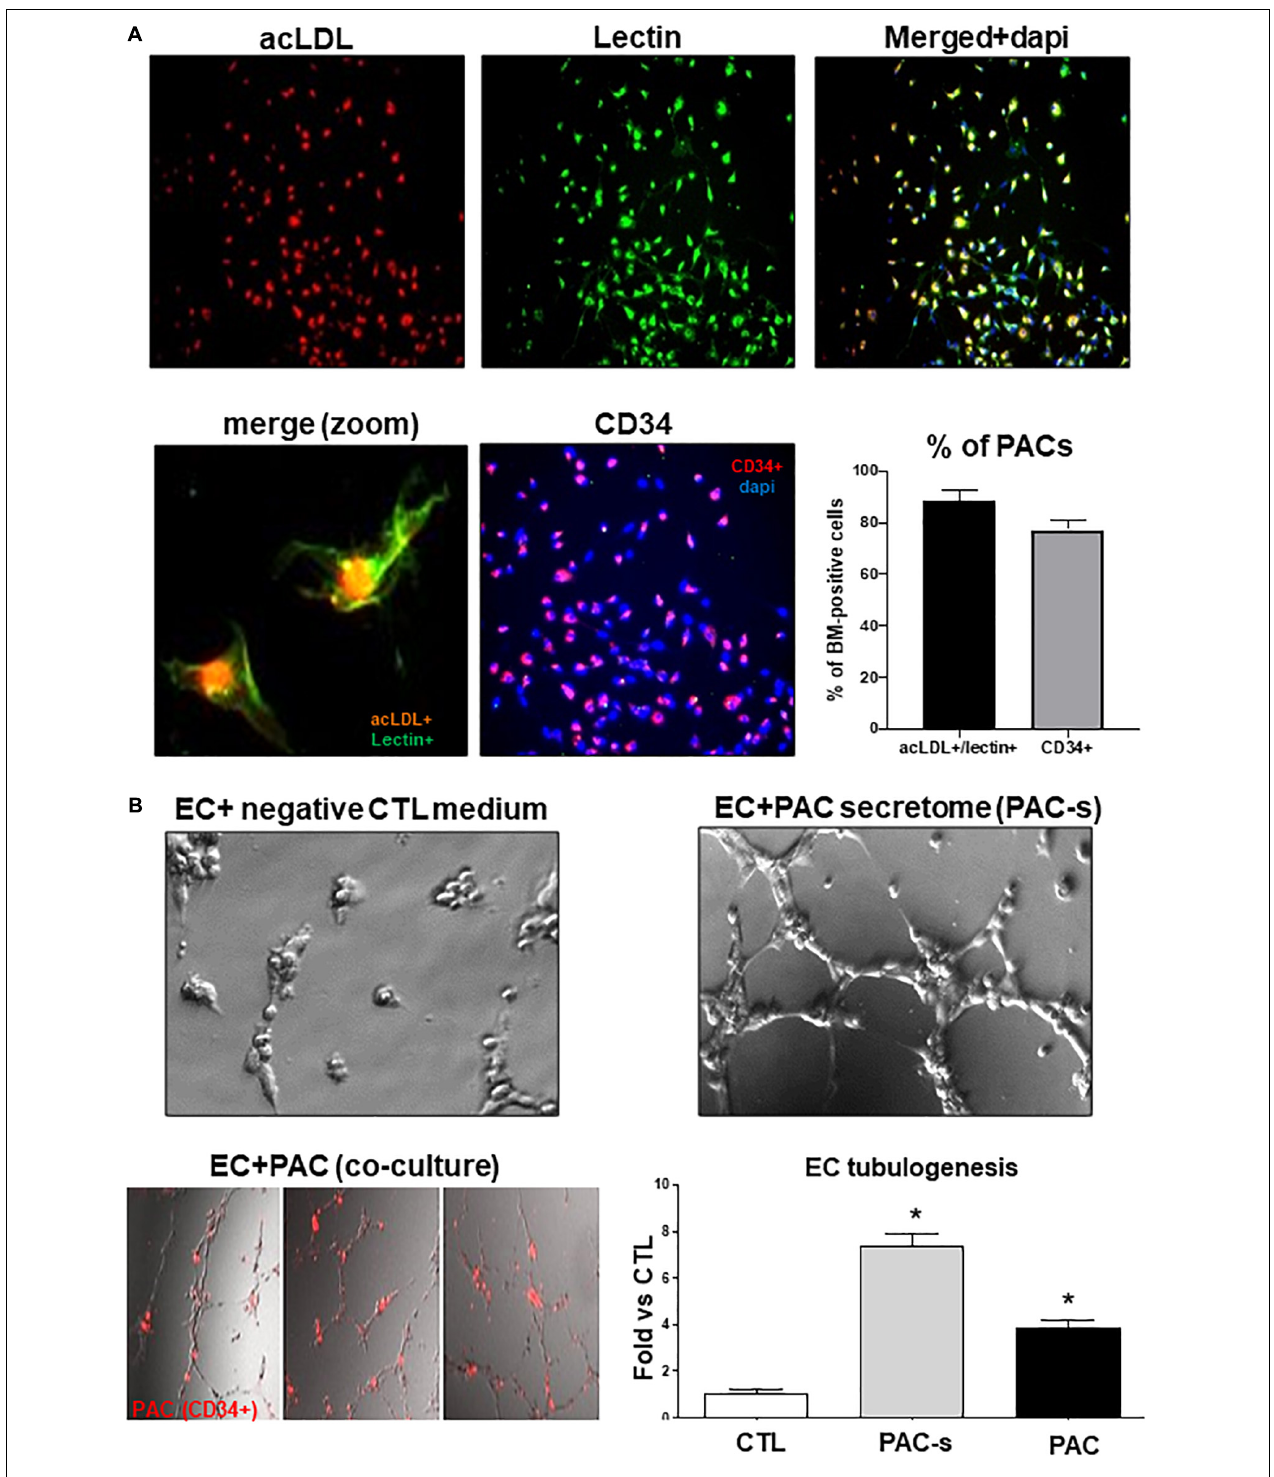
FIGURE 1 | Validation of PAC phenotype and efficacy of PAC-CM to promote retinal endothelial cells angiogenesis. (A) Representative pictures of PACs isolated from the bone marrow of rats and cultured ex vivo for 4 days. PACs were triple-stained with DAPI (blue), BS-1 lectin-FITC (green), and DiI-acLDL (red) or double stained for DAPI (blue) and CD34 (red). The percentage of isolated cells positive for Lectin + /acLDL + or CD34 + is shown on the graph. (B) Evaluation of the ability of PAC-s to promote HMREC angiogenesis in vitro (Matrigel assay) compared to CD34 + PACs (red). Culture media without PACs and growth factors was used as a negative control (CTL). Data are mean ± SEM. * P < 0.05 vs. CTL (control). N = 3–4